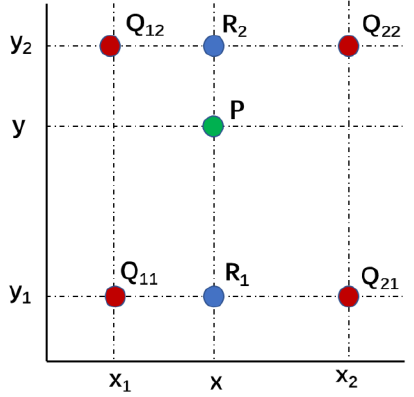
Figure 3. Principle diagram of bilinear interpolation.